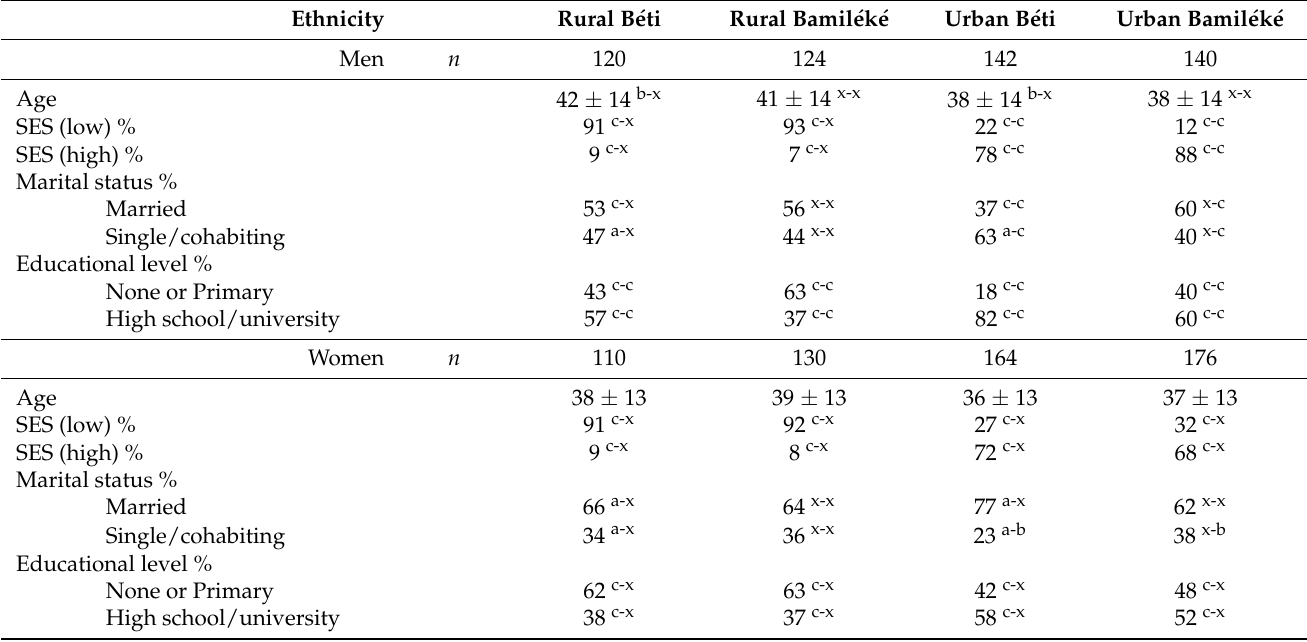
Table 1. Characteristics of the studied population 1